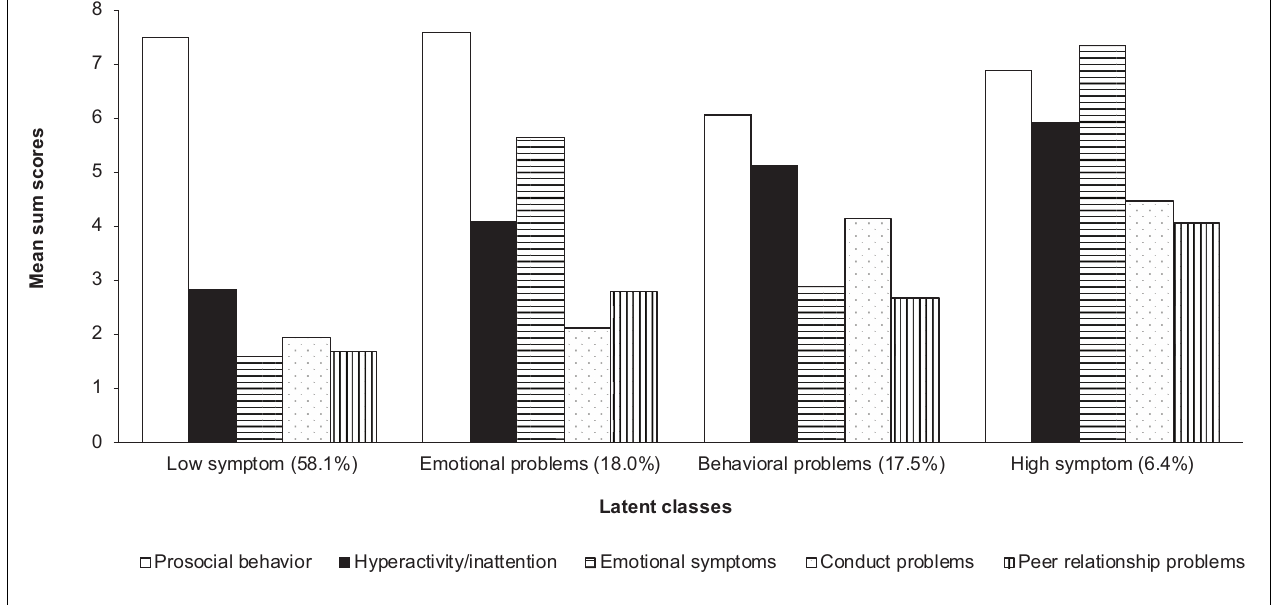
FIGURE 1 | Latent classes; based on socio-emotional functioning mean sum scores ( N = 1299).